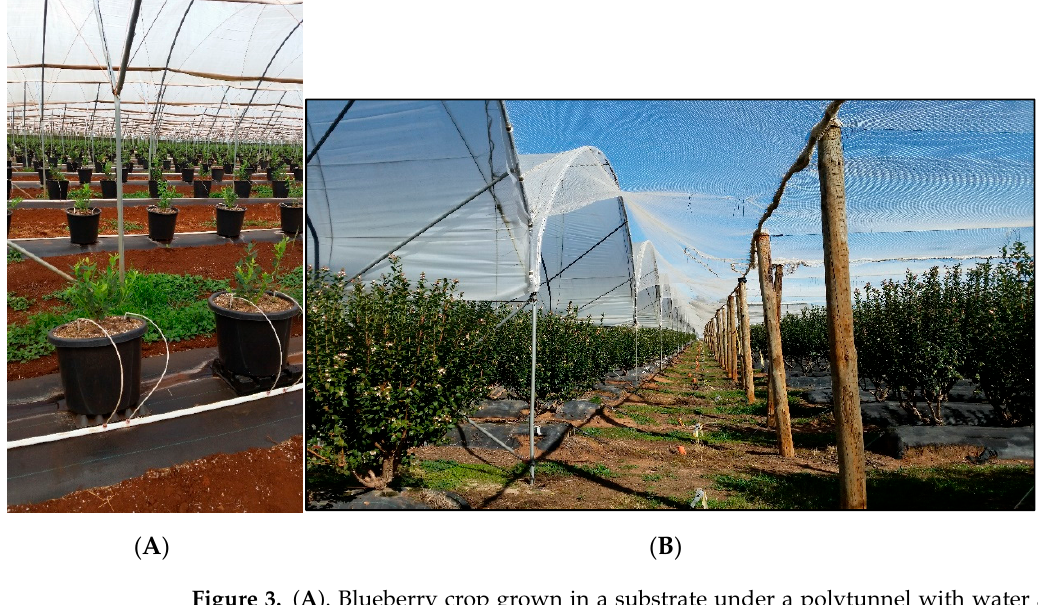
Figure 3. ( A ). Blueberry crop grown in a substrate under a polytunnel with water and nutrients supplied through fertigation. ( B ). A soil-grown blueberry crop protected by plastic cover ( left ) and bird net ( right ).